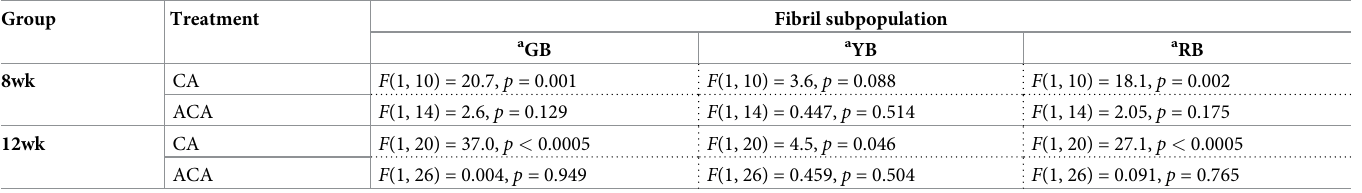
Table 4. Analysis of differences between specific groups of collagen fibrils, defined by specific birefringence, observed in uninjured and injured posterior capsules (PCs) isolated from the ACA-treated or control rabbits. Group Treatment